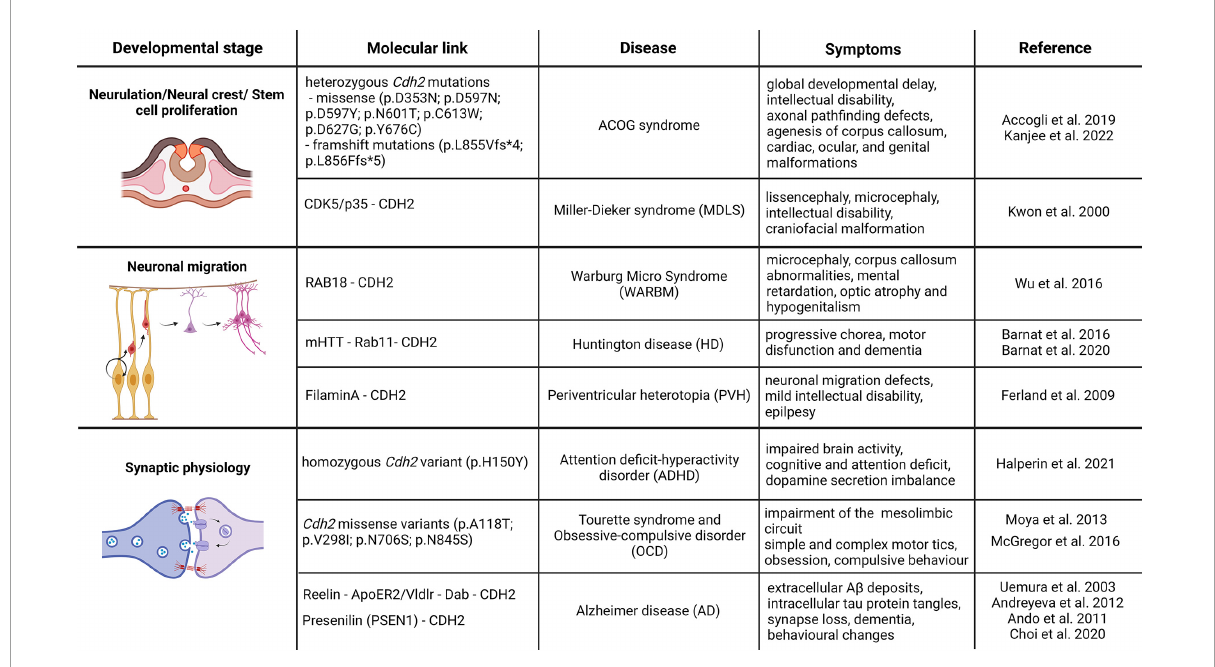
FIGURE2 CDH2-linked neurodevelopmental and neurodegenerative diseases. The schematic drawings in the figure represent the different developmental processes associated with CDH2 function and the associated diseases based on the genetic or direct molecular link. Image was created using